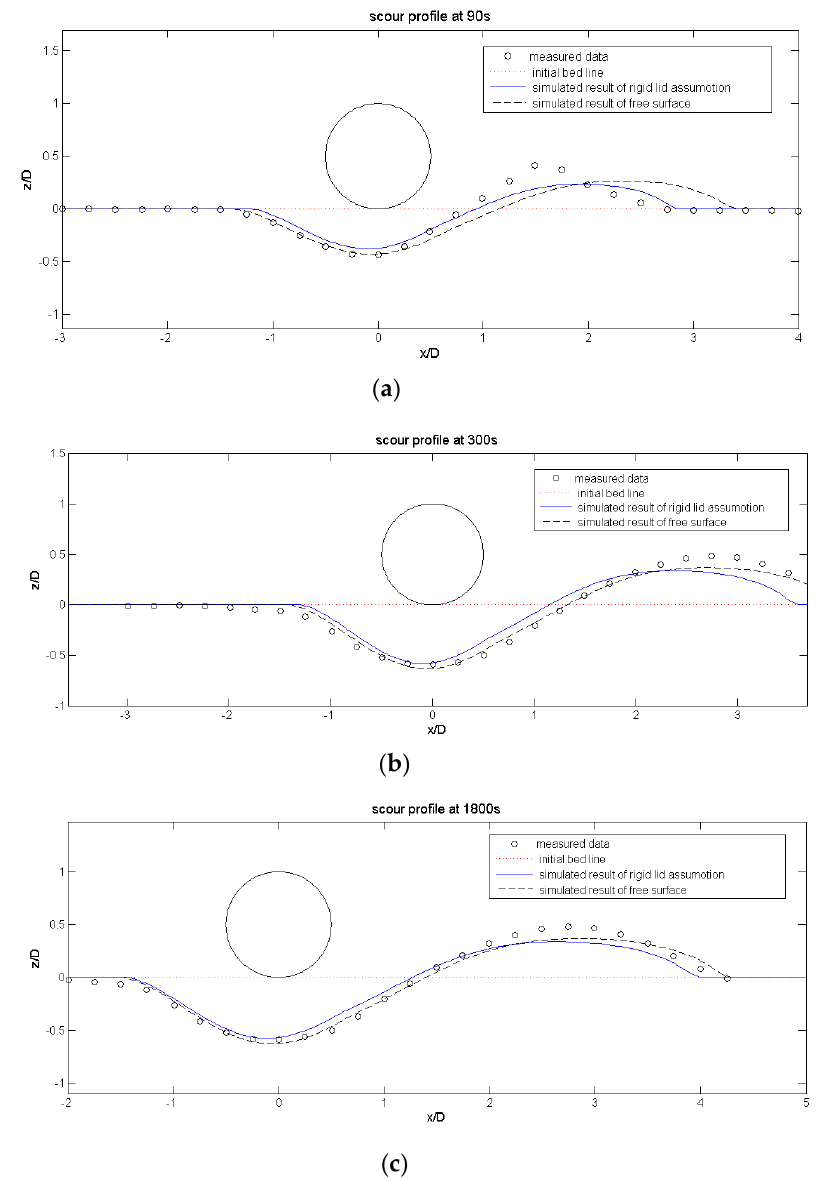
Figure 17. The scour profile of the free surface model and rigid lid assumption at different times in the case of Fr = 0.267, ( a ) T = 90 s; ( b ) T = 300 s; ( c ) T = 1800 s.